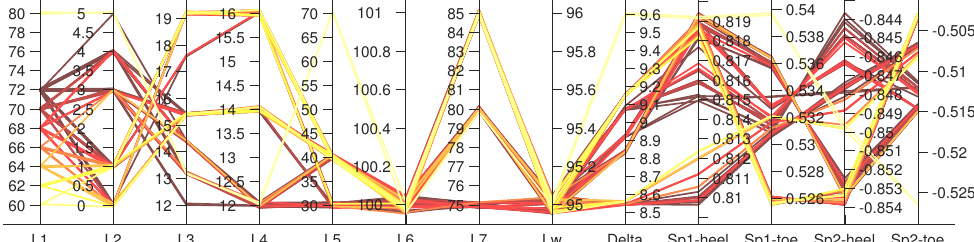
Figure 12. Parallel plot for top 100 design cases including eight shape variables ( L 6 and L w are constant) and five response parameters. Each line from left to right is a single design. Delta: ∆ max ;